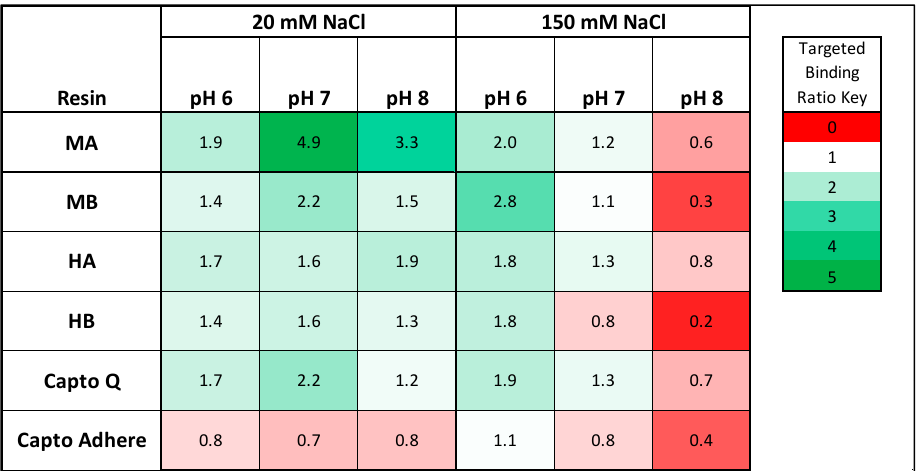
Figure 5. Resin HCP targeted binding ratio (TBR) by resin and buffer condition (N = 3). Resin HCP TBR is defined as the percent of HCP removed compared to the feed stream divided by the percent of mAb removed compared to the feed stream in static binding mode. In this analysis, HCP TBR > 1 indicates preferential binding to HCP as compared to IgG, and HCP TBR < 1 indicates preferential binding to IgG.